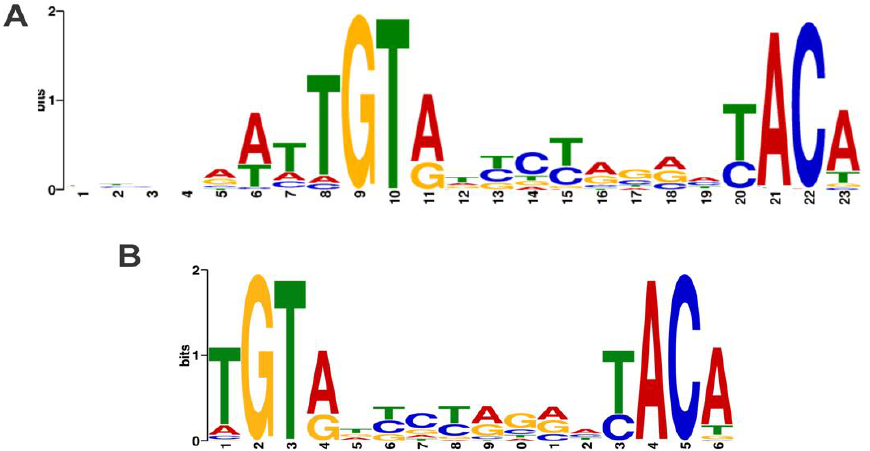
Figure 3. TTHB099-binding motifs. Sequence logos were determined using MEME software with an input of 1000 Round 7 DNA sequences. ( A ) MEME performed with no filters. ( B ) MEME performed using a palindromic filter.